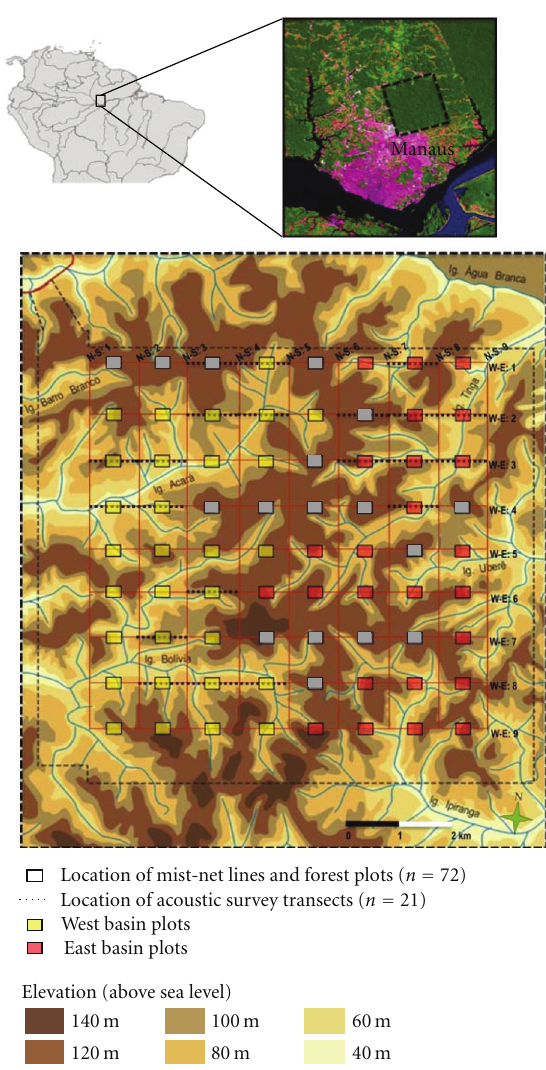
Figure 1: Location of the Reserva Florestal Adolpho Ducke (RFAD) in relation to the city of Manaus, Amazonas, Brazil (in pink), and spatial distribution of our sampling in the 8 × 8km trail grid. Squares located every km along the east-west trails represent the place where lines of 20 mist-nets and forest plots were located. Dashed lines of 1km represent the location of the acoustic surveys. Squares in yellow represent plots located in the western basin; squares in red represent plots located in the eastern basin. Squares in grey represents plots located along the central plateau, and were not used in the basin